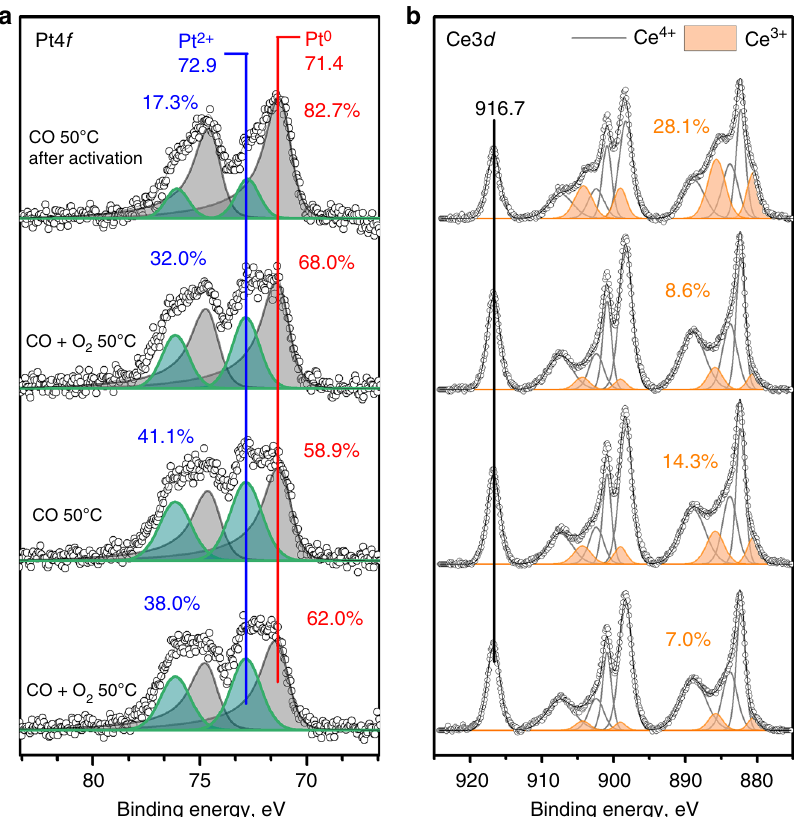
Fig. 5 NAP-XPS results for the 1wt.%Pt/CeO 2 TAPN catalyst synthesized by AT after activation in CO at 275 °C: a Pt4 f region, b Ce3 d region. The catalyst was sequentially exposed to different gas environments, starting at the top. The Pt/Ce ratio remained at ~0.030 throughout the